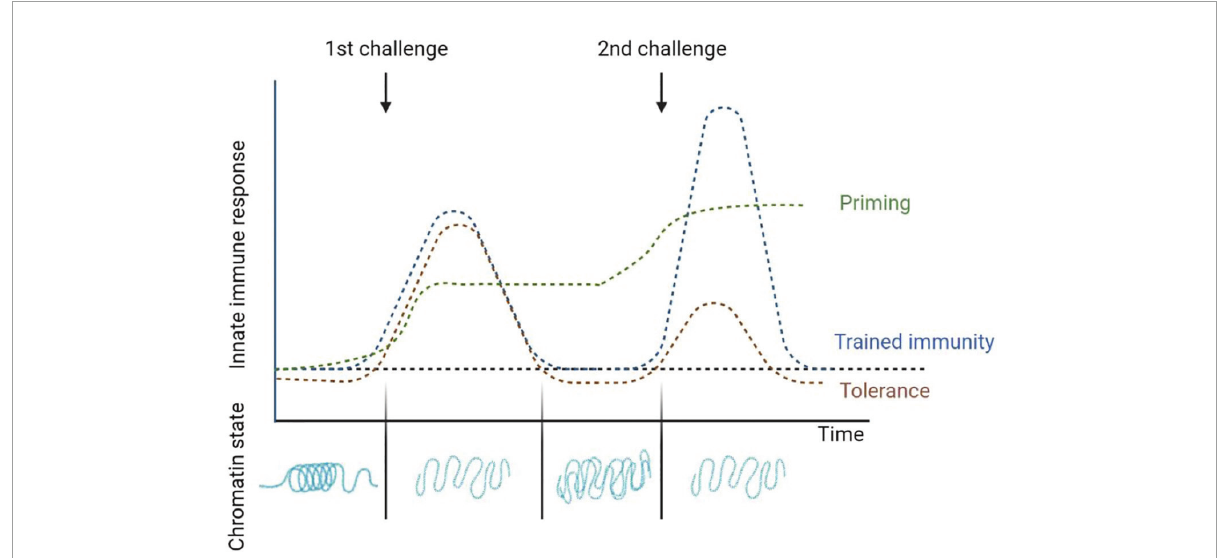
FIGURE1 Changes after the induction of innate immune memory. Priming is characterized by an activation of gene expression in innate immune cells that is sustained over time and does not return to basal levels before the second challenge. Often the response to the second stimulus is synergistic with the first one. In trained immunity the gene expressions levels return to basal levels when the first stimulus is removed, but epigenetic changes persist favoring a faster and higher immune response in subsequent infections. Finally, tolerance is the opposite to trained immunity, where after activation by a first stimulus and returning to basal levels the immune response is reduced in subsequent challenges. The flat dotted line represents the basal activation levels of the innate immune response in absence of infection. Adapted from Divangahi et al. (2020) and Netea et al.